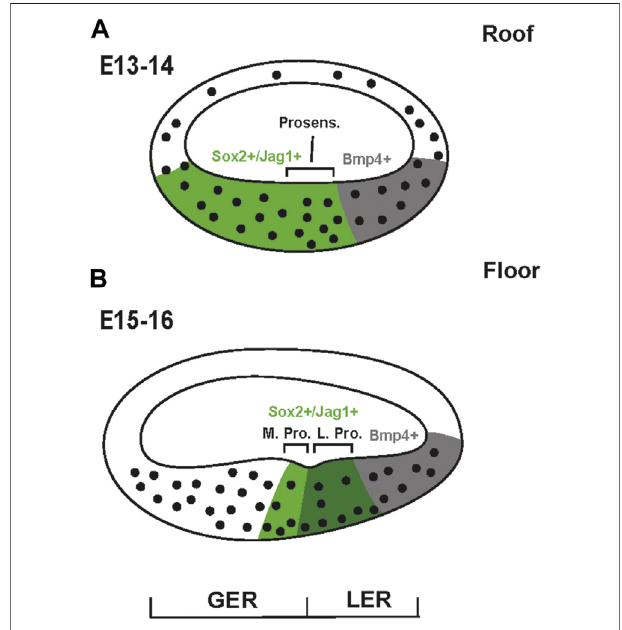
FIGURE 2 | Development of the cochlear duct. (A) Schematic cross- section of the mouse cochlear duct on E13 or E14. While the entire duct is comprised of morphologically undifferentiated epithelial cells, the fl oor is already signi fi cantly thicker than the roof. Previous results have demonstrated that the fl oor can already be divided into Sox2 + /Jag1 + and Bmp4 + domains. The prosensory region is located at the lateral edge of the Sox2 + /Jag1 + domain. (B) At E15-E16 the fl oor of the duct has become more differentiated. A physical notch in the epithelium de fi nes greater and lesser epithelial ridges (GER and LER) which separate the Medial and Lateral Prosensory domains (M. Pro. and L. Pro.). By this stage, expression of Sox2 and Jag1 is largely con fi ned to the prosensory domain. The lateral domain of Bmp4 -expression still persists.